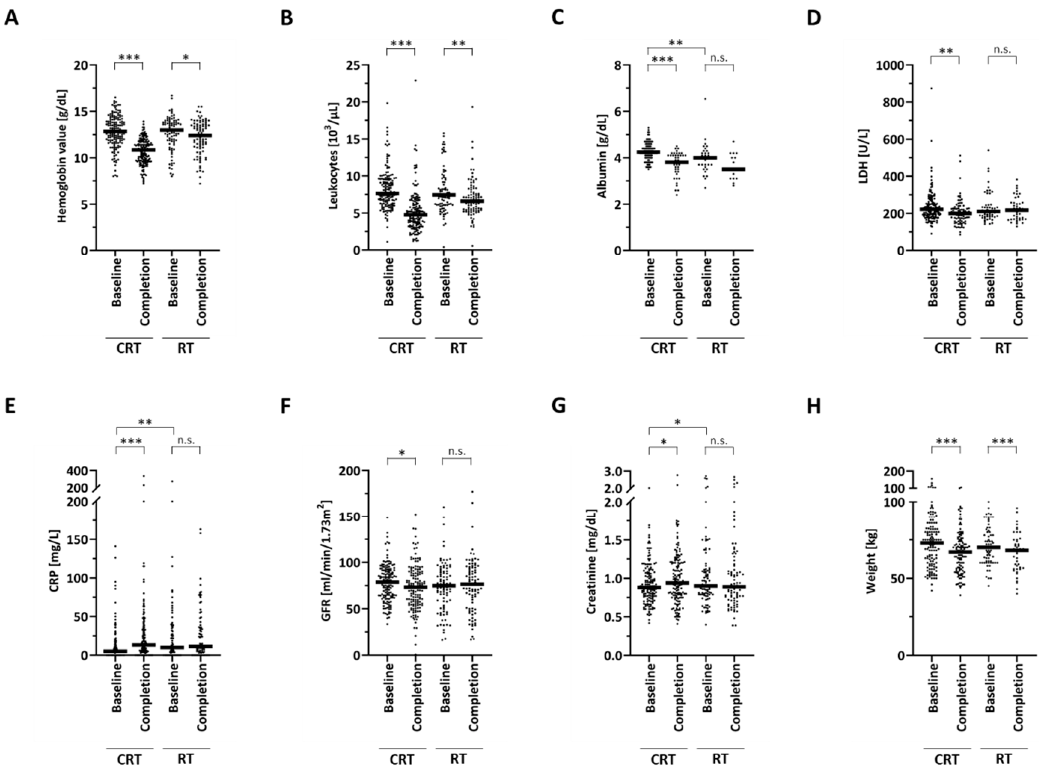
Figure 1. Scatter dot plots visualizing the distribution of several blood parameters, namely hemoglobin ( A ), leukocyte count ( B ), albumin ( C ), LDH ( D ), CRP ( E ), GFR ( F ), creatinine ( G ), and body weight ( H ) during the course of chemoradiation (CRT) or radiotherapy (RT). Each dot plot represents a parameter of one patient, and the horizontal line shows the median sample value. Two-sided unpaired t -tests were carried out to test for di ff erences between the baseline values in the chemoradiation and radiotherapy group, while two-sided paired t -tests were conducted in order to detect di ff erences between the baseline and completion groups. * p < 0.05, ** p < 0.01, *** p < 0.001, n.s. = not significant. Number of available values at baseline was n = 235 (hemoglobin), n = 234 (leukocytes), n = 129 (albumin), n = 199 (LDH) n = 145 (CRP), n = 234 (GFR), n = 234 (creatinine) and n = 193 (body weight).